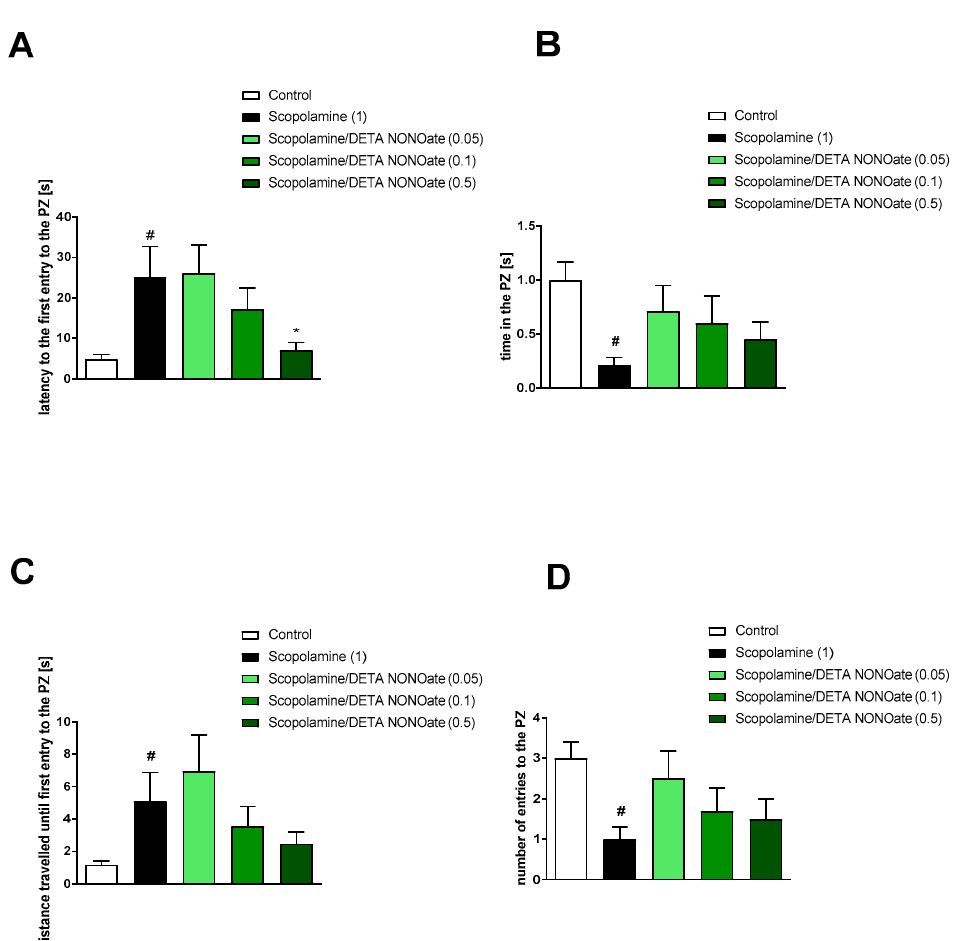
Figure 12. The effects of DETA NONOate on scopolamine-induced deficits in the retention of spatial memory in the MWM of CD1 mice. PZ-related parameters. ( A ) the latency to the first entry into the PZ, ( B ) the time in the PZ, ( C ) the distance travelled in the PZ, ( D ) the number of entries into the PZ. The values are expressed as the means ± SEM. # p < 0.001 vs. control group and * p < 0.05 vs. scopolamine-treated animals (N = 8–10).